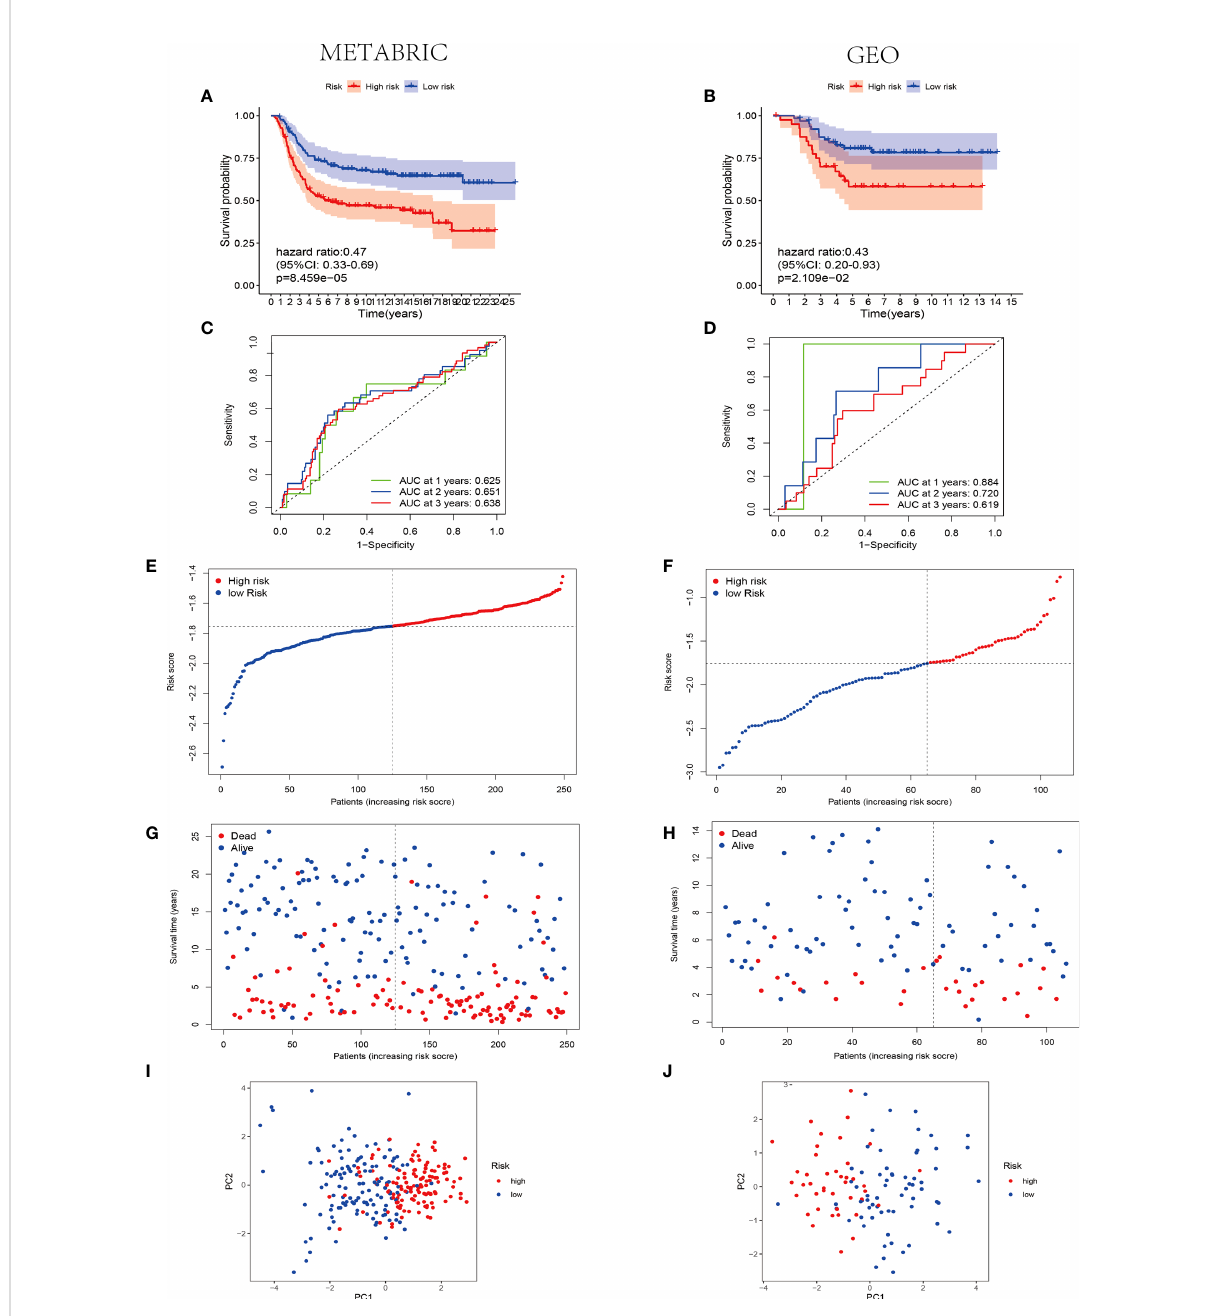
FIGURE 5 Ef fi cacy and prognosis analysis of the pyroptosis-associated signature of patients with TNBC. (A, B) Kaplan – Meier survival curves for patients with TNBC from the METABRIC (A) and GEO groups (B) , strati fi ed on the basis of risk scores (high vs. low); the hazard ratio of the METABRIC and GEO cohorts are 0.47 and 0.43, respectively (95% CI = 0.33 – 0.69 for the METABRIC cohort and 0.20 – 0.93 for the GEO cohort); comparisons of the survival time in high- and low-risk groups with log-rank tests (P = 8.459E-05 and P = 2.109E-02, respectively). (C, D) ROC curve analysis of model accuracy for predicting the prognosis of patients with TNBC at 1, 2, and 3 years in the METABRIC (C) and GEO (D) groups. (E, F) The median value and distribution of the risk score in the METABRIC (E) and GEO (F) groups. (G, H) The distributions of survival status and risk scores in the METABRIC (G) and GEO (H) groups. (I, J) PCA analysis plot of the METABRIC (I) and GEO groups (J) . Red point indicates patients with high risk, and blue point indicates patients with low